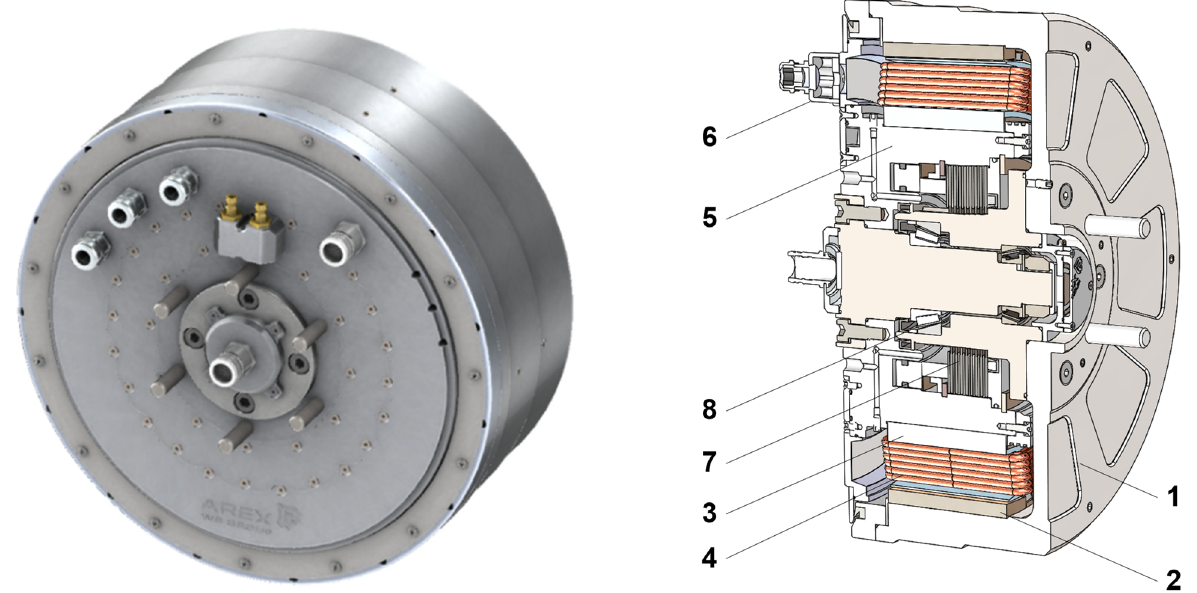
Figure 7. View of the prototype and a cross-section of the drive module for mounting in the Electric Light Commercial Vehicle wheel developed by AREX Sp. z o.o. 1—rotor, 2—magnets, 3—stator’s magnetic core, 4—stator winding coils, 5—supporting structure, 6—entry for supply wires, 7—wet brake, 8—bearings system.